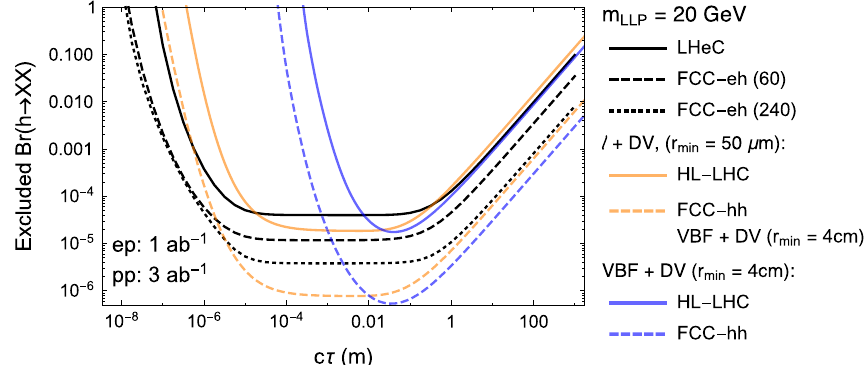
LLP mass in the plot is 20GeV. For comparison, an estimate for the sensitivity of proton colliders without background is shown (blue), as well as a very optimistic estimate which assumes extremely short-lived LLP reconstruction (orange), from [377]. This plot is taken from [334]